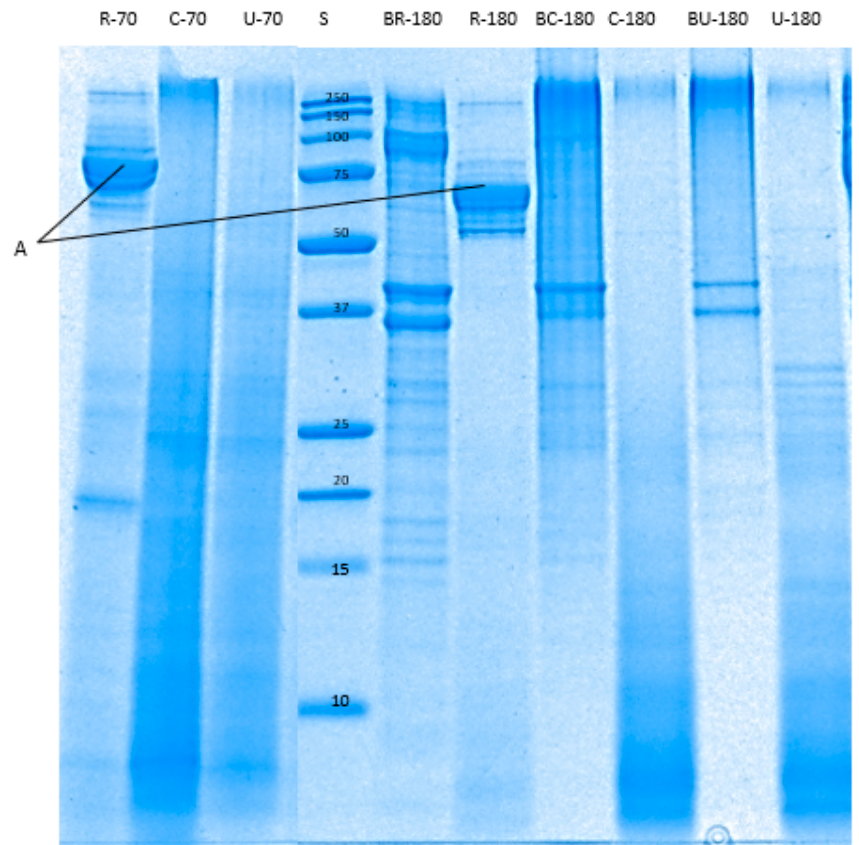
Figure 9. Tricine SDS-PAGE electrophoretogram showing protein profile of the digested p¯aua samples after 10 or 120 min of small-intestinal digestion. S, standard; R, raw control; C, cooked control (no pre-treatment prior to canning); U, cooked ultrasound pre-treated; BR, BC and BU, are digested